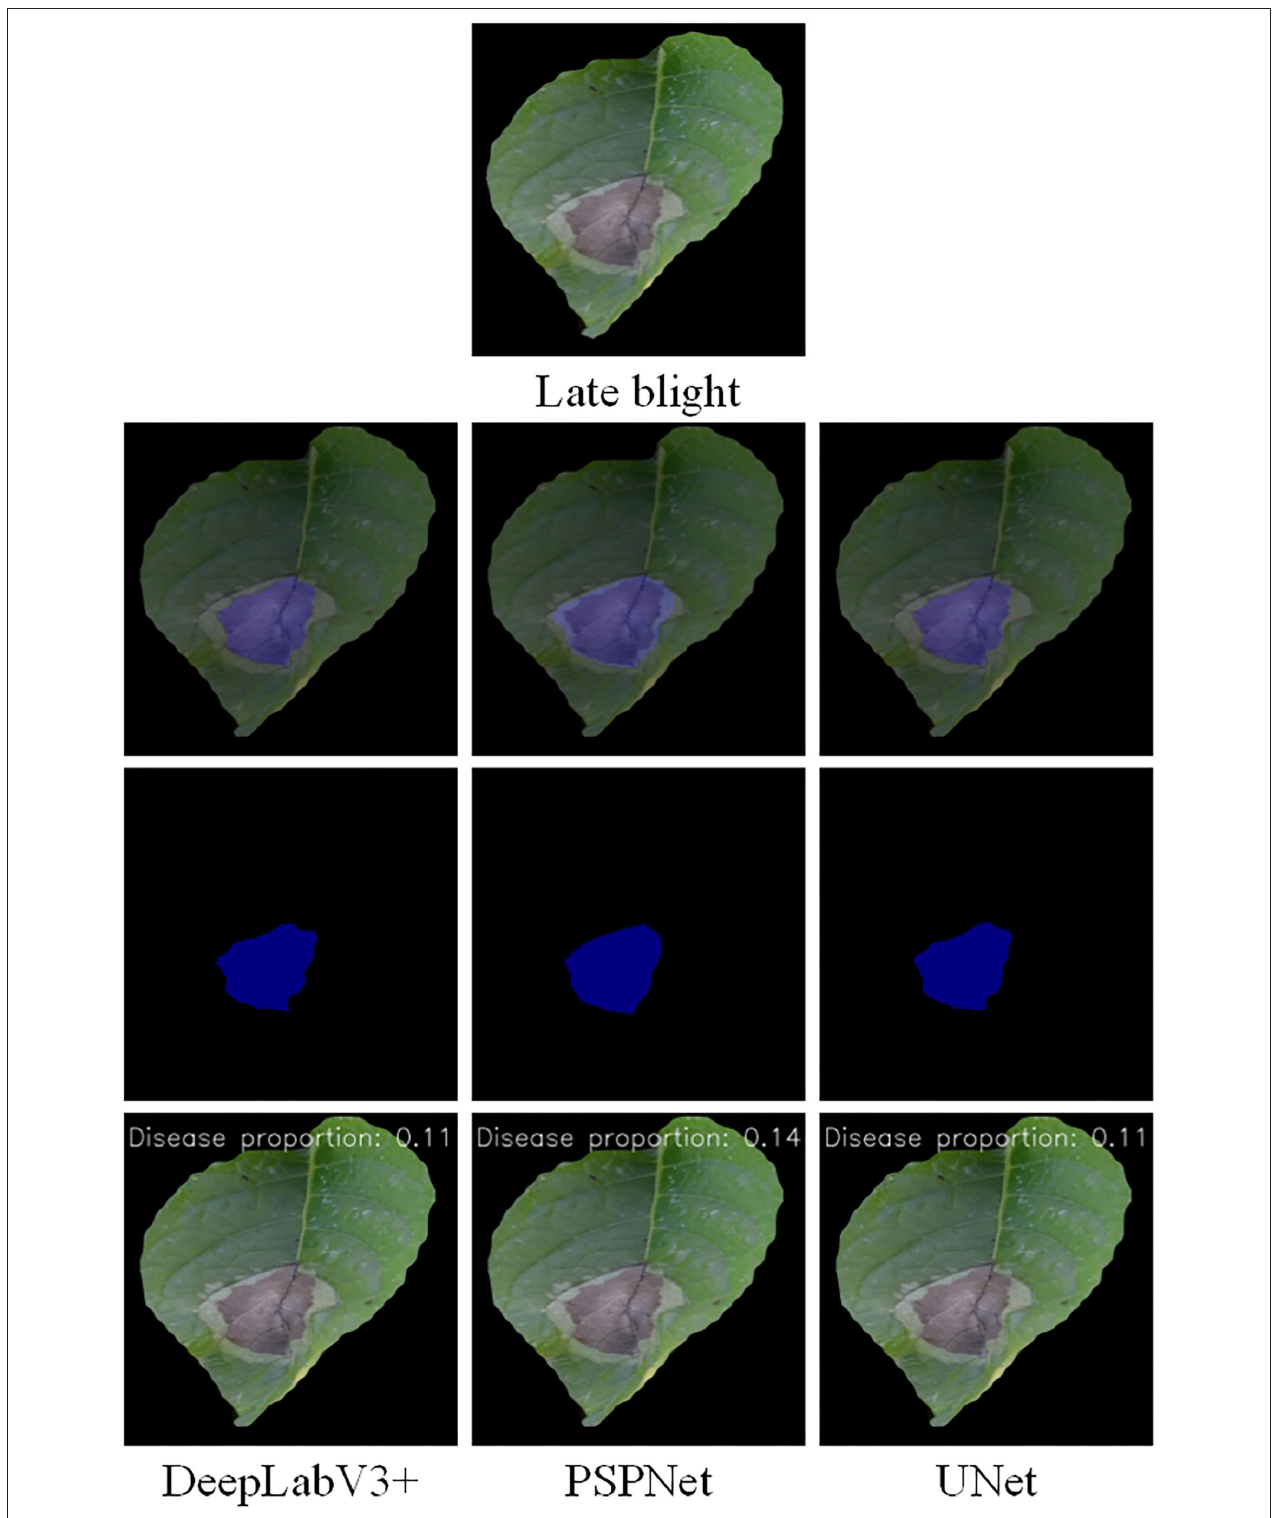
FIGURE 8 | Semantic segmentation results of late blight under the three models.